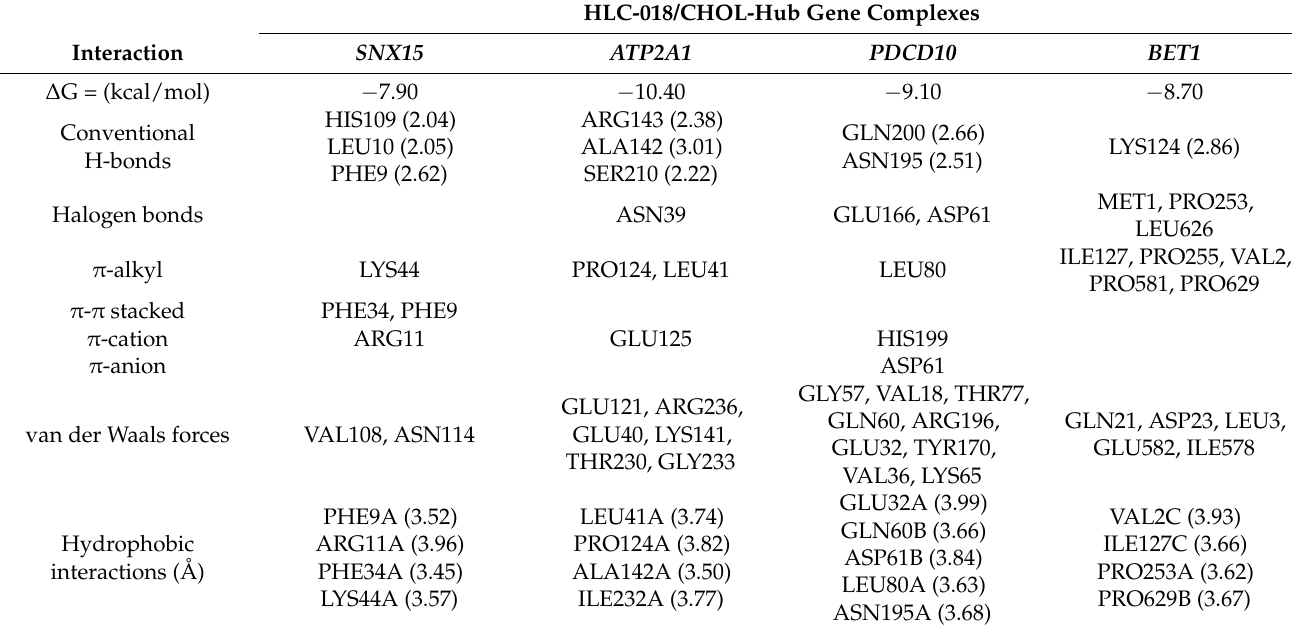
Table 3. Docking profile of HLC-018 with cholangiocarcinoma (CHOL)-hub genes. HLC-018/CHOL-Hub Gene Complexes